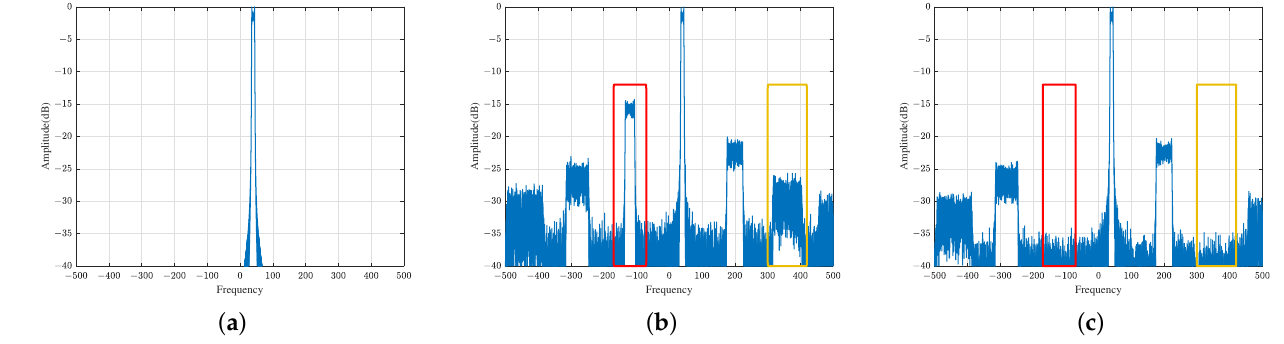
Figure 5. The spectrum of a wideband signal with a high oversampling rate set to 20. ( a ) Results with high-precision quantization. ( b ) Results with one-bit quantization. ( c ) Results with the proposed two-bit